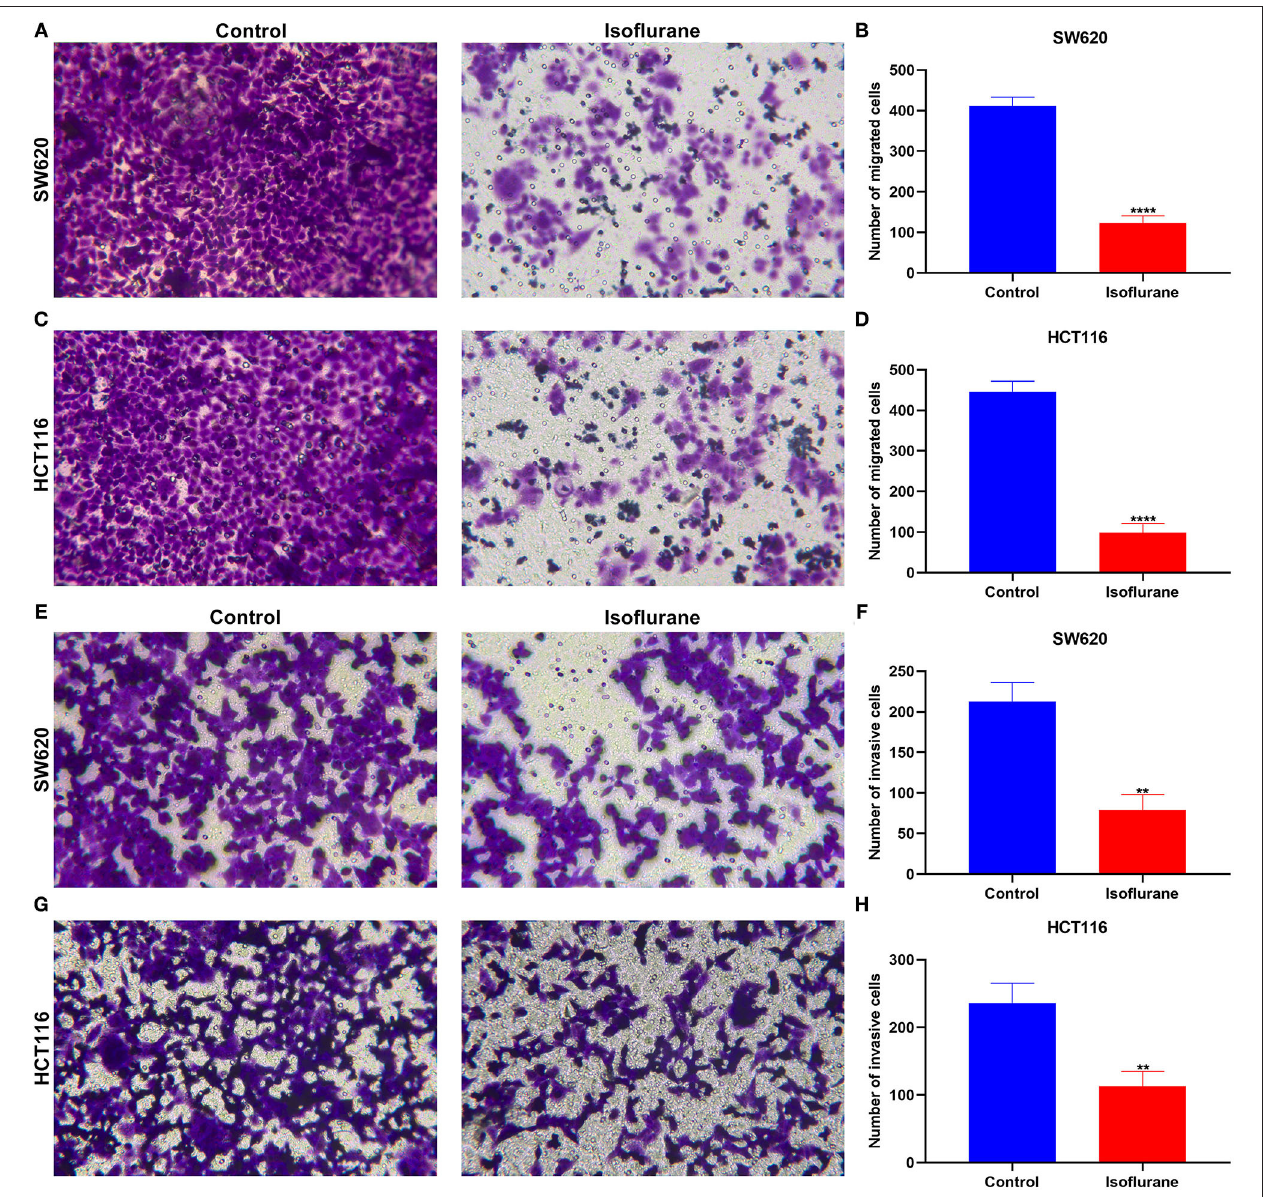
FIGURE 3 | The suppressed role of isoflurane on migrated and invasive capacities of CRC cells. The number of migrated (A,B) SW620 and (C,D) HCT116 cells following 40 µ M isoflurane treatment. The number of invasive (E,F) SW620 and (G,H) HCT116 cells exposed to 40 µ M isoflurane. ** p < 0.01; **** p < 0.0001.